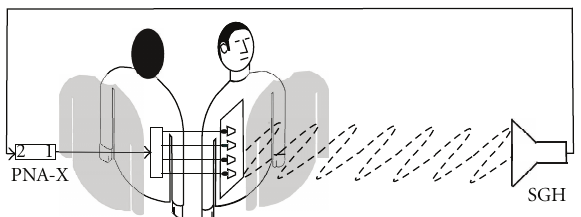
Figure 15: Entire antenna system placed on the human body: port 2 of the Agilent N5242A PNA-X Network Analyzer is connected to the Standard Gain Horn (SGH) and port 1 is connected to the 4- port power